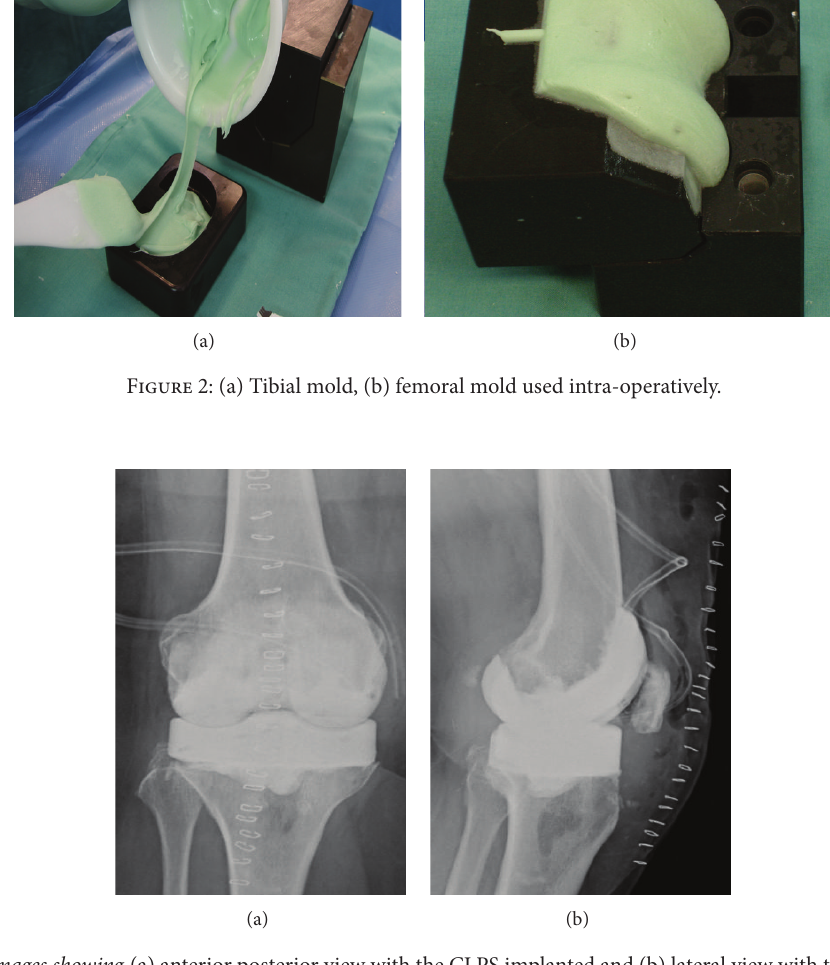
Figure 3: X-ray images showing (a) anterior posterior view with the CLPS implanted and (b) lateral view with the CLPS implanted.